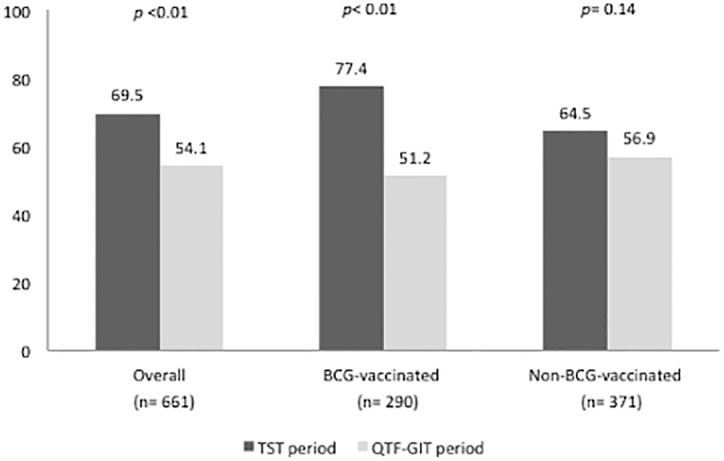
Proportion of TB infection diagnosis by study period and BCG-vaccination status.